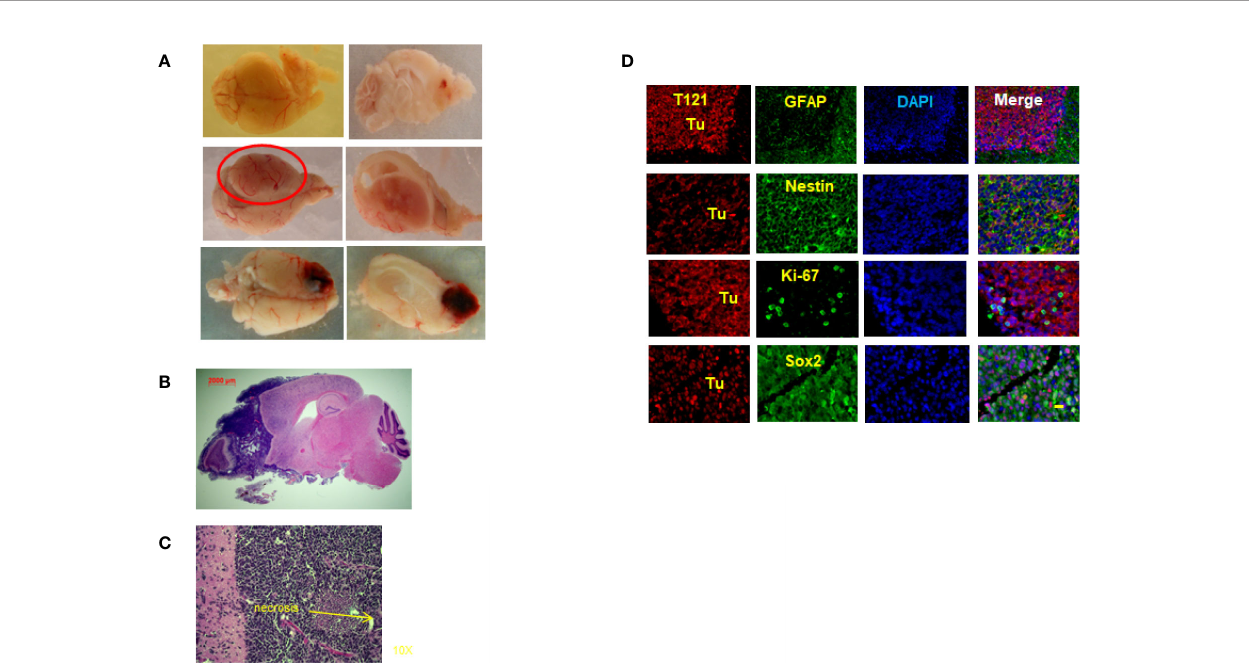
FIGURE 5 | Rb-TS inactivated mice develop High Grade Astrocytomas. (A) Representative images showing High Grade Astrocytomas at different locations in the brain with whole brain (left side) and brain and tumor sagittally sectioned (right side). (B) Whole sagittal section of the brain, H&E stained showing the High Grade Astrocytoma. (C) Representative zoomed in image of H&E stained tumor image showing characteristic necrosis and pleomorphic nuclei in an High Grade Astrocytoma. (D) Immuno fl uorescence of sagittal sections of the brain with High Grade Astrocytoma T 121 showing T 121 -red, GFAP, Nestin, Ki-67, Sox2-green, merge and DAPI (nuclei) in blue. Tu indicate tumor area. Scale bar indicates 20